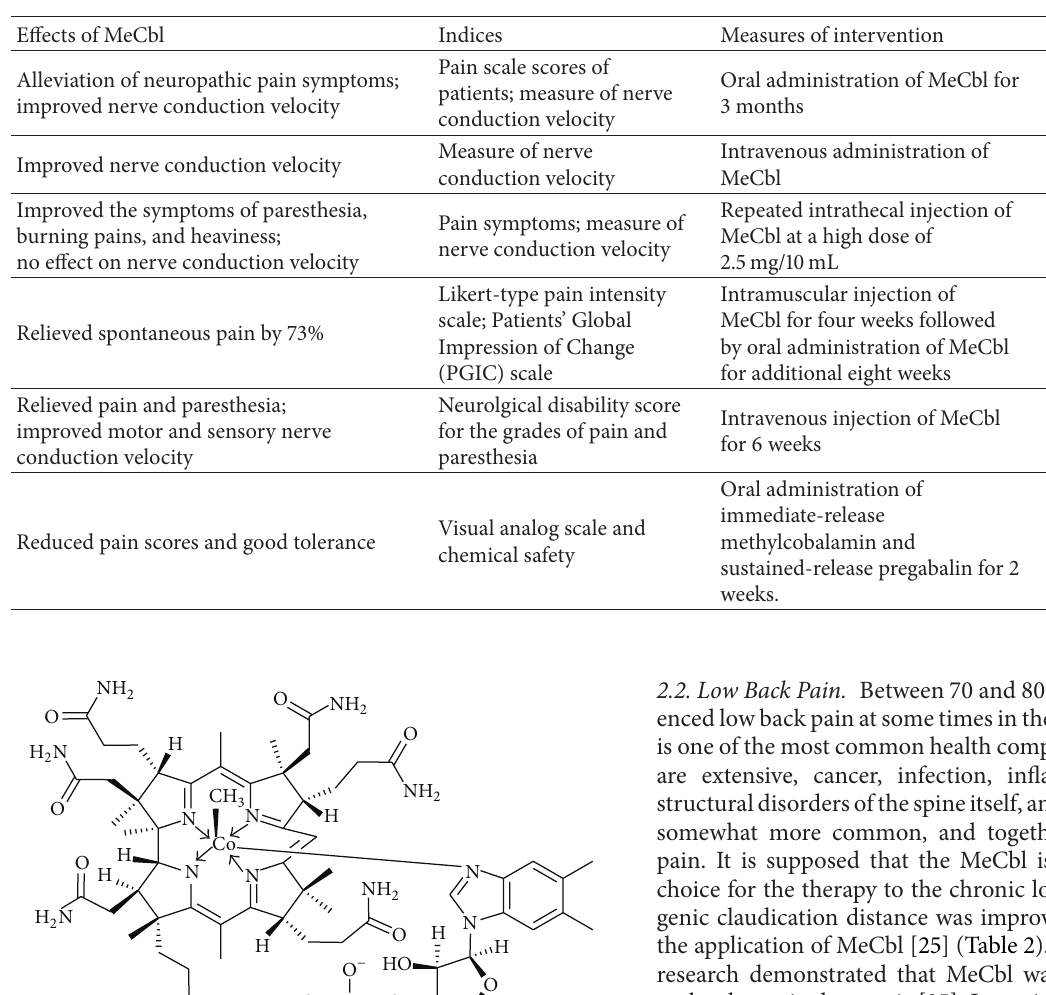
Table 1: The analgesic effect of MeCbl or combined use with other drugs on patients with diabetic neuropathic pain.